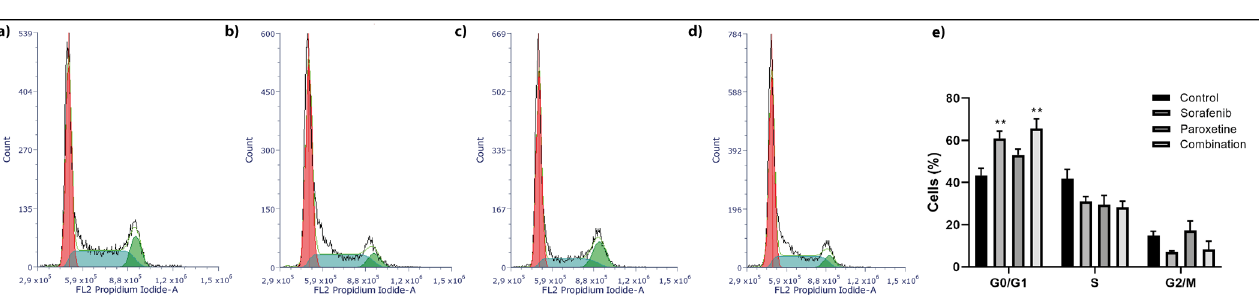
FIGURE 3 - Cell cycle distribution in cells without any treatment (A), sorafenib treated (B), paroxetine treated (C), and co-treated with both drugs (D). The bar graph represents the percentages of cells at the G0/G1, S, and G2/M phases. Two-way ANOVA showed a significant difference among the groups (F[6,21] = 6.932). **Significant difference in comparison to the control group at P <